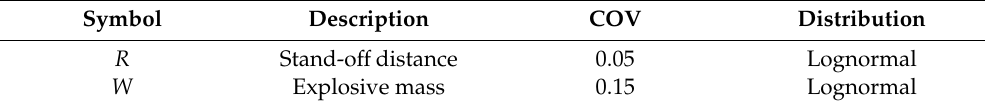
Table 6. Probabilistic Analysis Input